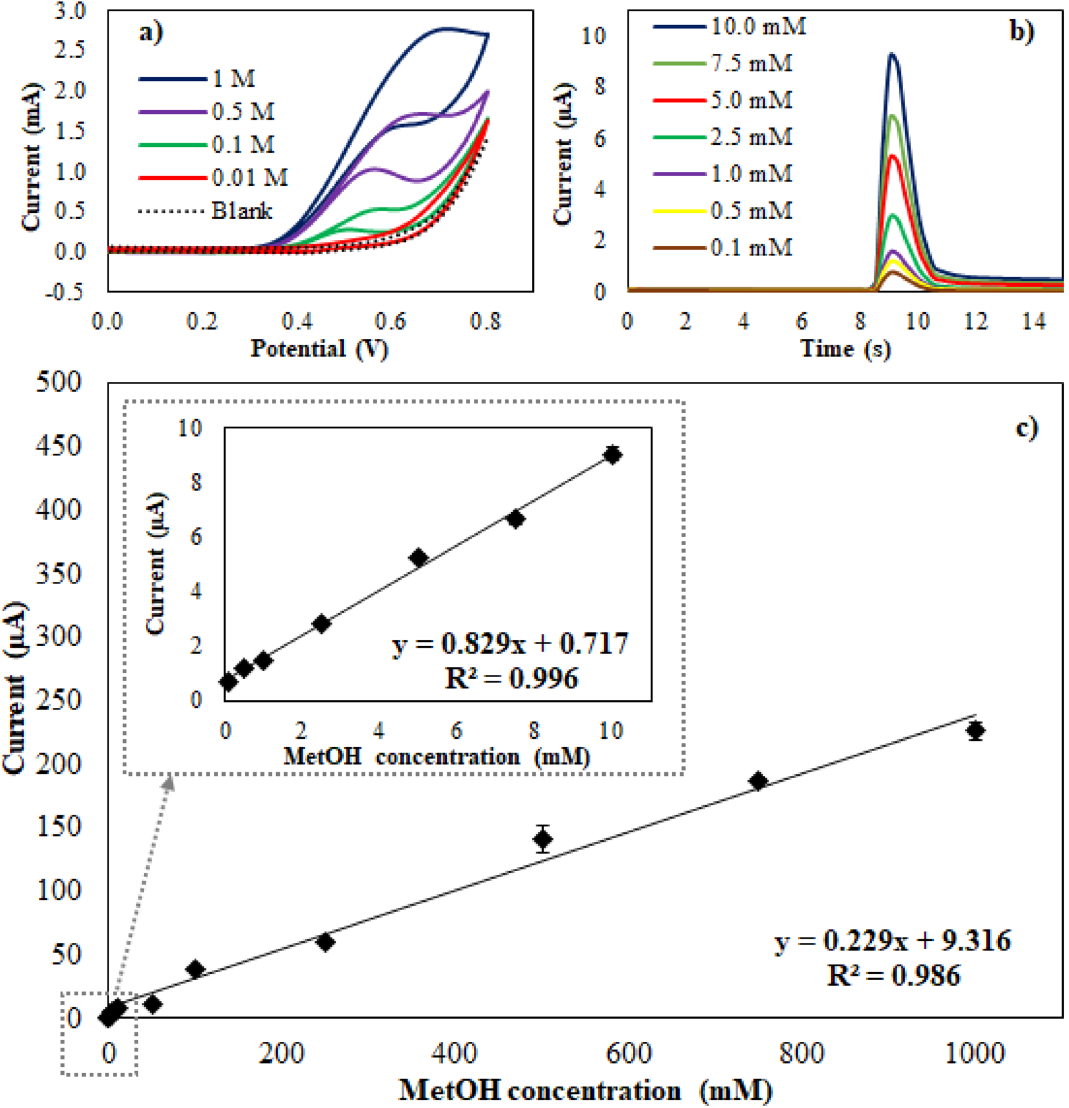
Figure 6. ( a ) Cyclic voltammograms of 0.1 M NaOH containing different concentrations of methanol varied form 0.01–1 M on Cu/Pt/BDD electrode. ( b ) Chronoamperograms of methanol detection in 0.1 M NaOH in the presence of methanol concentrations ranging from 0.1 to 10 mM using Cu/Pt/BDD electrode coupled with SIA system under the optimized conditions: 0.50 V initial potential for 15 s. ( c ) Calibration curve obtained from chronoamperometry for the methanol determination (0.1–1000 mM) using Cu/Pt/BDD electrode coupled with SIA system in an alkaline solution. Inset showed the calibration plot for 0.1–10 mM methanol.